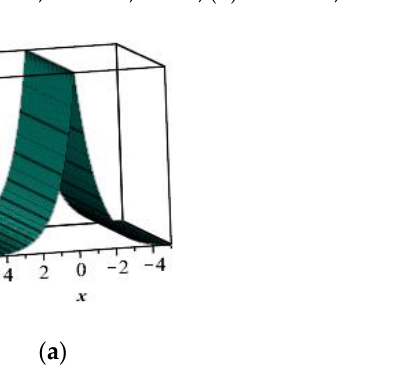
Figure 4. Comparison plots of ψ FRDTM and ψ HPM of Camassa–Holm (CH) equation for − 2 ≤ x ≤ 2. ( a ) c = 0.005, k = 0.5, t = 0.05, α = 1; ( b ) c = 0.005, k = 0.5, t = 0.1, α = 1.